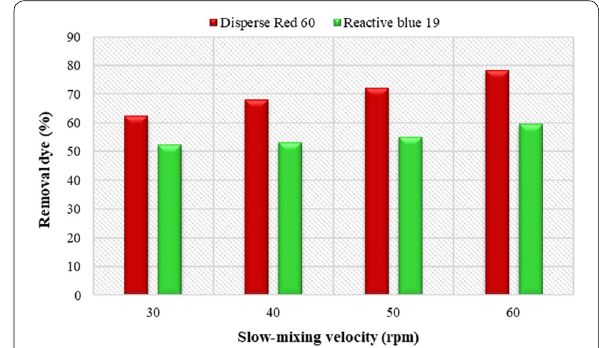
Fig. 5 Effect of slow-mixing speed on removal efficiency of Disperse red 60 and Reactive blue 19 dyes. (Initial pH 11, Alcea rosea = concentration 200 mg/L and initial dye concentration 40 mg/L = = for Disperse experiments; initial pH 11, concentration 250 mg/L = = and initial dye concentration 20 mg/L for Reactive experiments) =